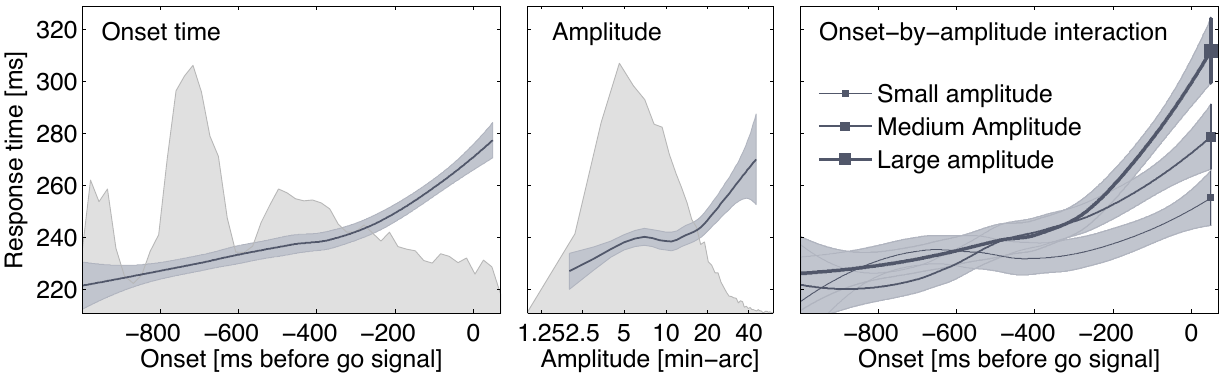
Figure 5 . Main effects (panels 1 and 2) and interaction (panel 3) of microsaccade onset and microsaccade amplitude on SRT. Data were collapsed across conditions. For panel 3, microsaccade amplitudes were cut into three quantiles to illustrate the inter- action; small, medium, and large amplitudes have the ranges [1.34,6.44], (6.44,11.9], and (11.9,59.9] min-arc, respectively. Error bands represent 95% confidence intervals; smoothing is based on local polynomial regression fitting. Background histograms in panels 1 and 2 show distributions of the predictors, with binning set to 10 ms for onset times and 1 min-arc for